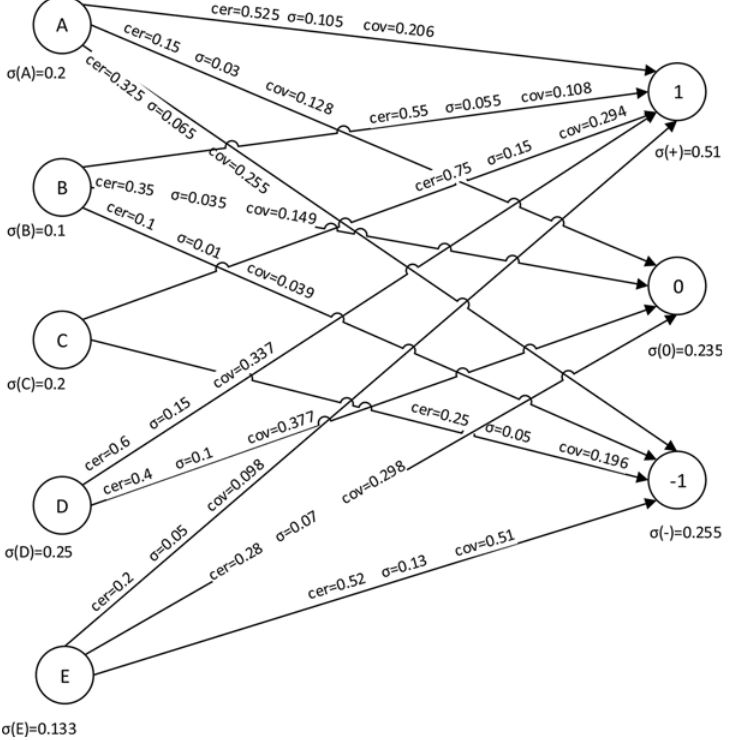
Fig 4. Flow graph for Table